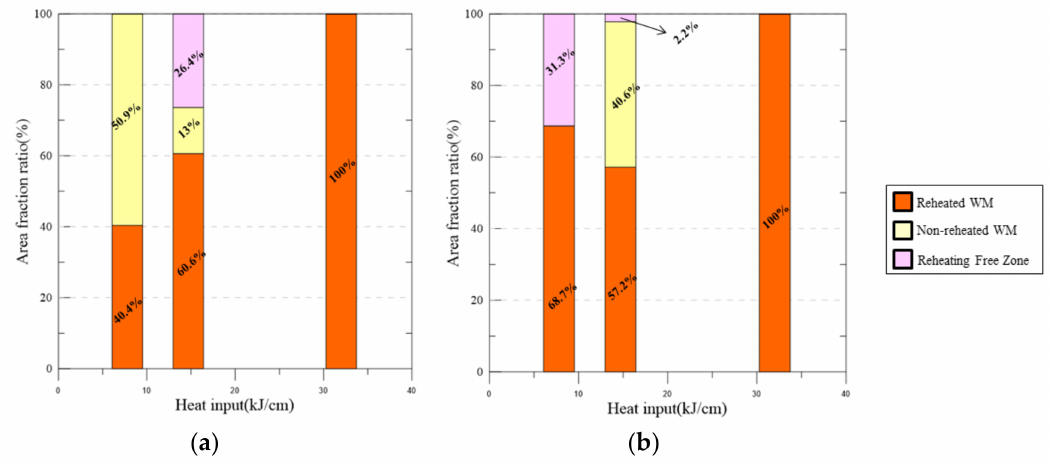
Figure 14. Area fraction variation with the welding heat input change; ( a ) center region; and ( b ) edge